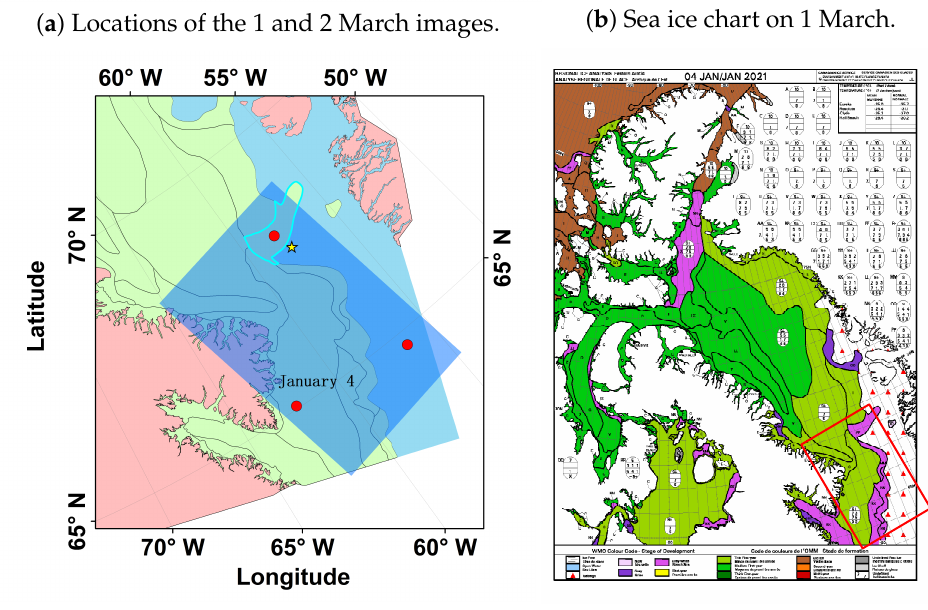
( c ) Location of the 4 January image. ( d ) Sea ice chart on 4 January. Figure 1. ( a ) The 1 and 2 March RCM images laid over sea ice charts. Light green represents ice, light blue represents water and pink represents land. The yellow star represents the location with sea-state information. The 1 March image was used for selecting training samples, and the first testing set samples of NI and water. The 2 March imagewasis used for selecting the first testing set samples of OI/FYI. Green dots indicate the locations for selecting the training samples. Red dots indicate the locations for choosing the testing samples. ( b ) Regional sea ice chart in the Eastern Arctic for the week of 1 March 2021. Red rectangles indicate the coverages of the 1 and 2 March RCM images. ( c ) The 4 January RCM image laid over a sea ice chart (color codes are same as those in ( a )). The stars are the locations with sea-state information near the testing samples. The 4 January image was used for selecting the second testing set samples. Red dots also indicate the locations where the testing samples were collected. ( d ) Regional sea ice chart in the Eastern Arctic for the week of 4 January 2021. The red rectangle illustrates the coverage of the 4 January RCM